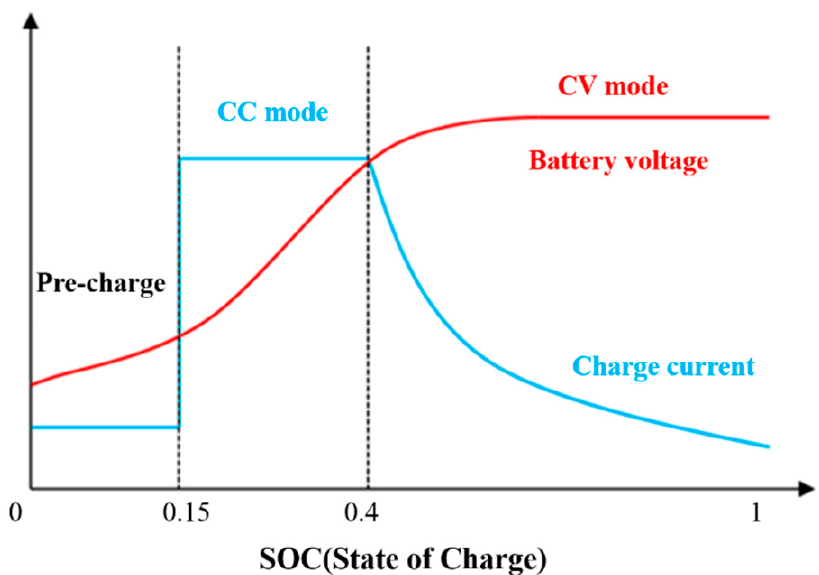
Figure 1. Typical charging curve of a lithium battery.